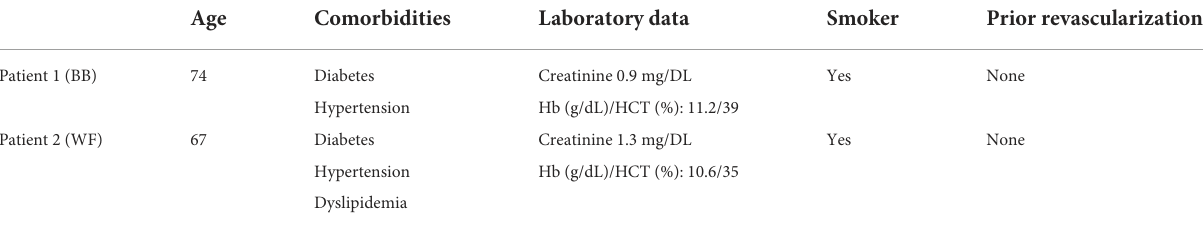
TABLE 1 Clinical characteristics.